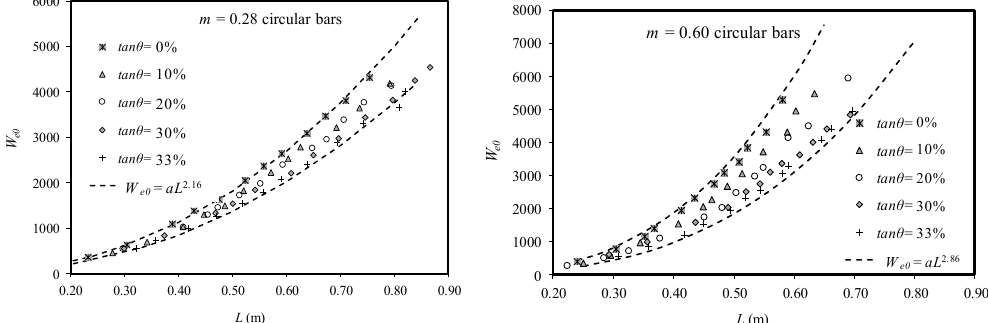
Figure 17. Reynolds number at the beginning of the rack R e0 as a function of the wetted rack length L , for T-shaped flat bars with void ratio m = 0.28.